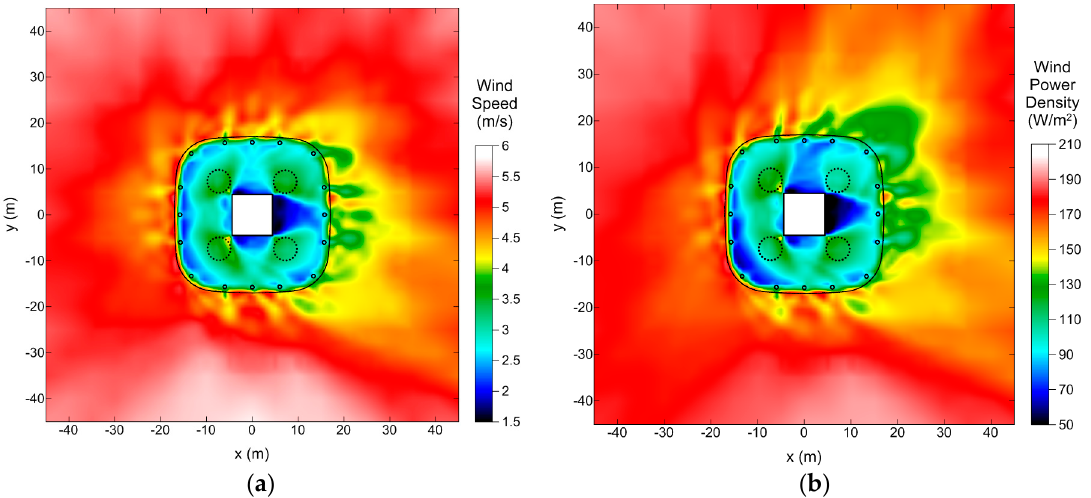
Figure 17. Wind resource map at 2 m above the Lotte World Tower roof (dimensions in meters): ( a ) mean wind speed map; and ( b ) wind power density map.